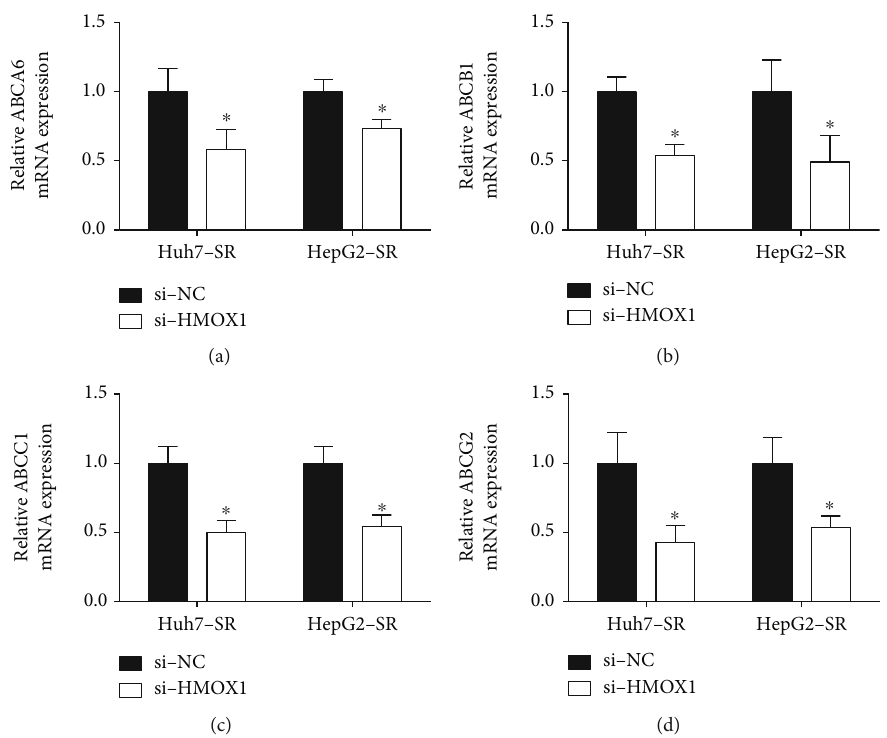
Figure 8: Silence of HMOX1 downregulated the expression of ABCA6, ABCB1, ABCC1, and ABCG2 in sorafenib-resistant cells. (a) Relative mRNA expression of ABCA6 in Huh7-SR and HepG2-SR cells after being transfected with si-NC or si-HMOX1. (b) Relative mRNA expression of ABCB1 in Huh7-SR and HepG2-SR cells after being transfected with si-NC or si-HMOX1. (c) Relative mRNA expression of ABCC1 in Huh7-SR and HepG2-SR cells after being transfected with si-NC or si-HMOX1. (d) Relative mRNA expression of ABCG2 in Huh7-SR and HepG2-SR cells after being transfected with si-NC or si-HMOX1. N = 3 . ∗ P < 0 : 05